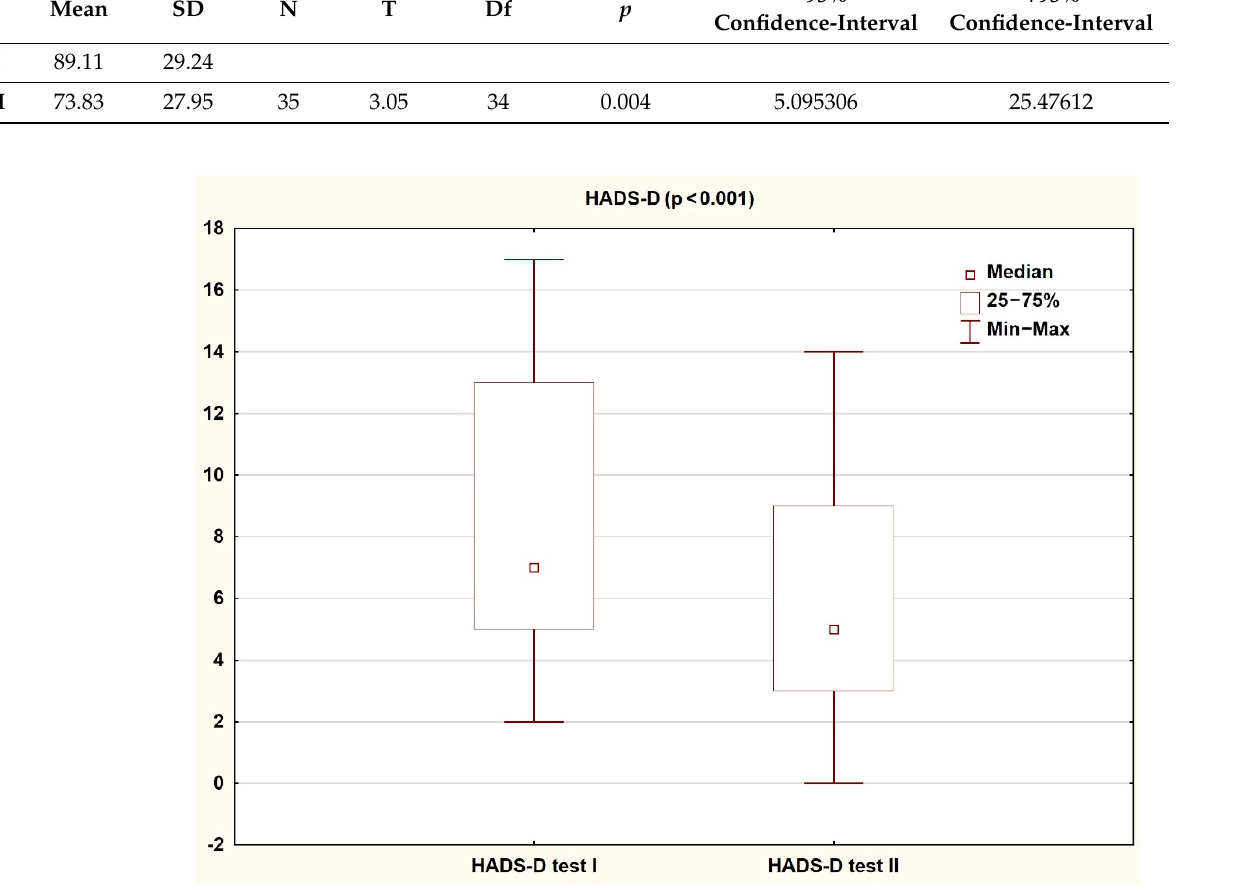
Figure 3. Patient results in the HADS-A subscale during the first and second study (Wilcoxon test).